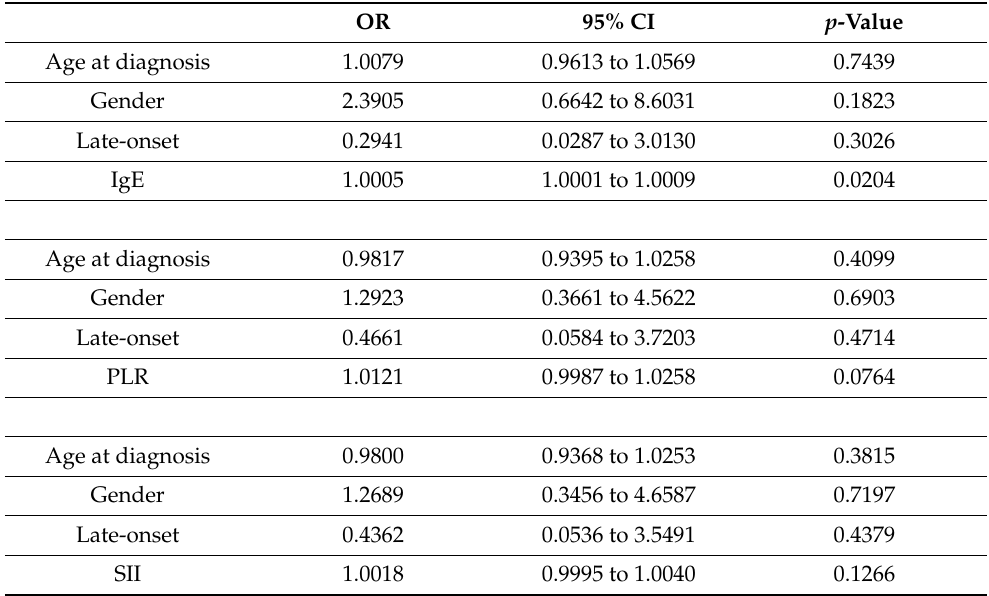
Table 5. Odds ratio, for laboratory parameters, obtained by multivariate logistic regression